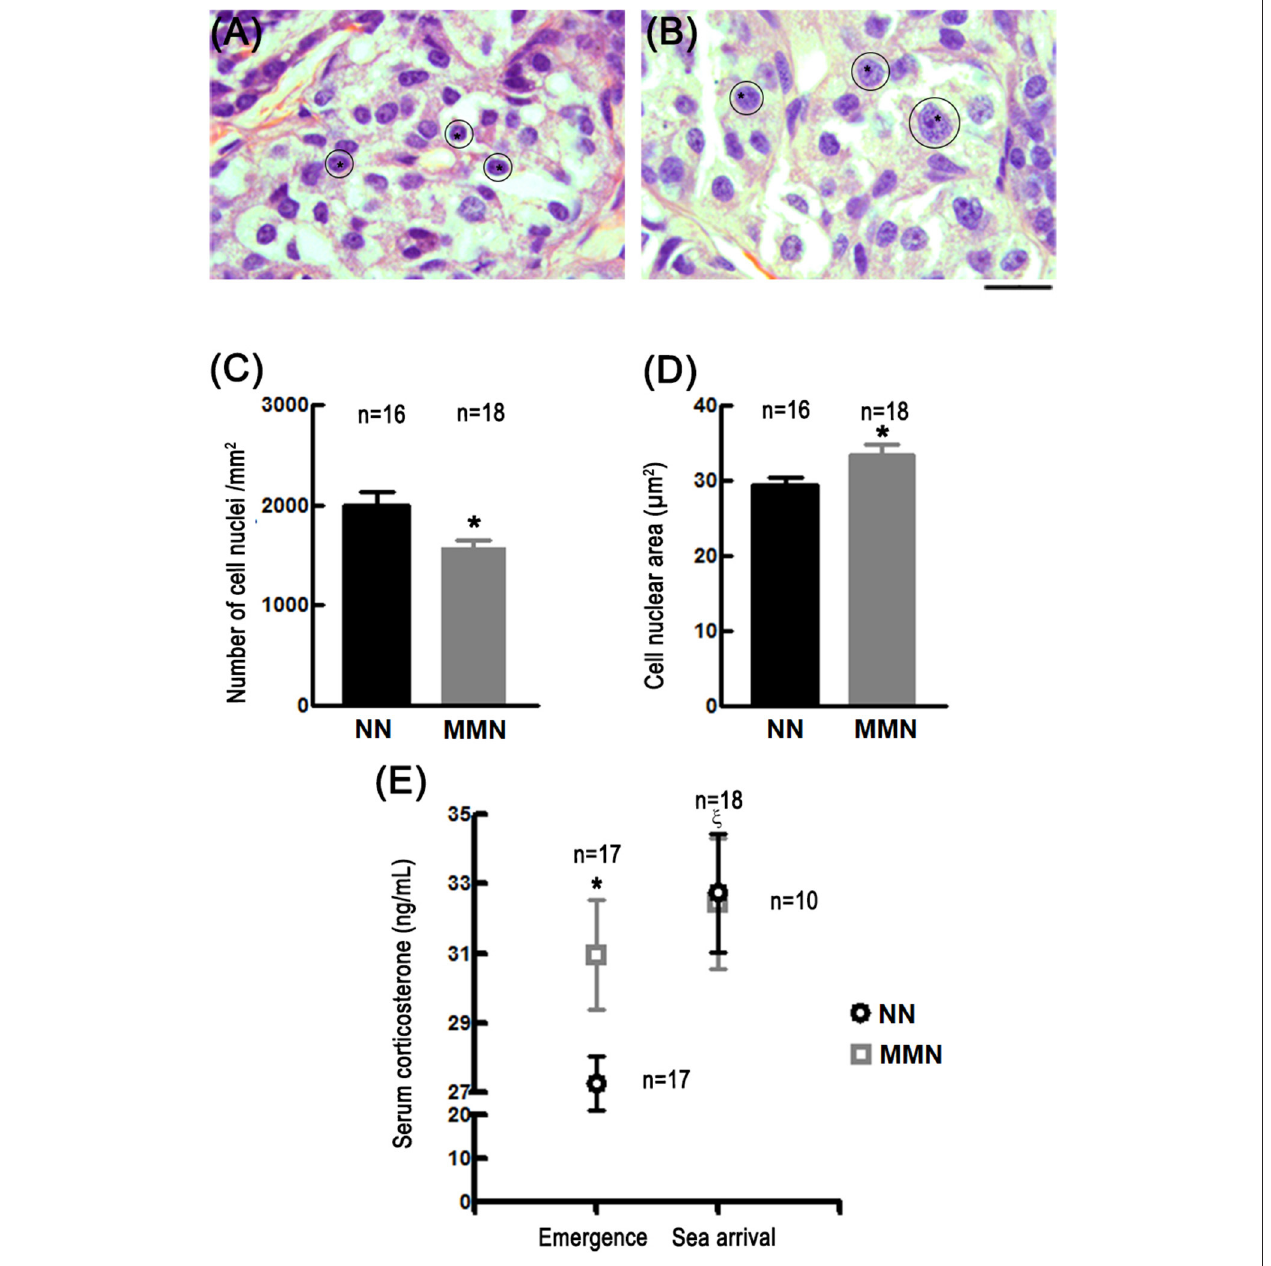
FIGURE 1 | Photomicrographs of histological sections stained with hematoxylin-eosin showing glucocorticoid-producing cells in the interrenal gland of hatchlings that emerged from NN (A) or MMN (B). Notice the enlarged cell nuclei (asterisks and outlines) and hypertrophied cytoplasm in MMN hatchlings. Since lipids were extracted during histological processing, the cytoplasm is observed as a white space surrounding the cell nuclei. Scale bar = 20 µ m. Bar graphs that show the nuclear cell density [ C; Nested ANOVA F (1, 28) = 7.77, * p = 0.009] and cell nuclear area [ D; Nested ANOVA F (1, 28) = 11.14, * p = 0.002] of glucocorticoid-producing cells in NN and MMN hatchlings. (E) Graph showing corticosterone serum levels in hatchlings from NN or MMN at nest emergence and at sea arrival [Nested ANOVA F (2, 51) = 5.58, p = 0.006]. At emergence, serum basal levels were significantly higher in MMN than in NN hatchlings (Fisher LSD means comparison test, * p = 0.044); no differences were observed between groups at sea arrival. At sea arrival, the magnitude of the evoked release of corticosterone was significantly lower MMN than in NN hatchlings (intragroup comparisons; Fisher LSD means comparison test, ξ p =